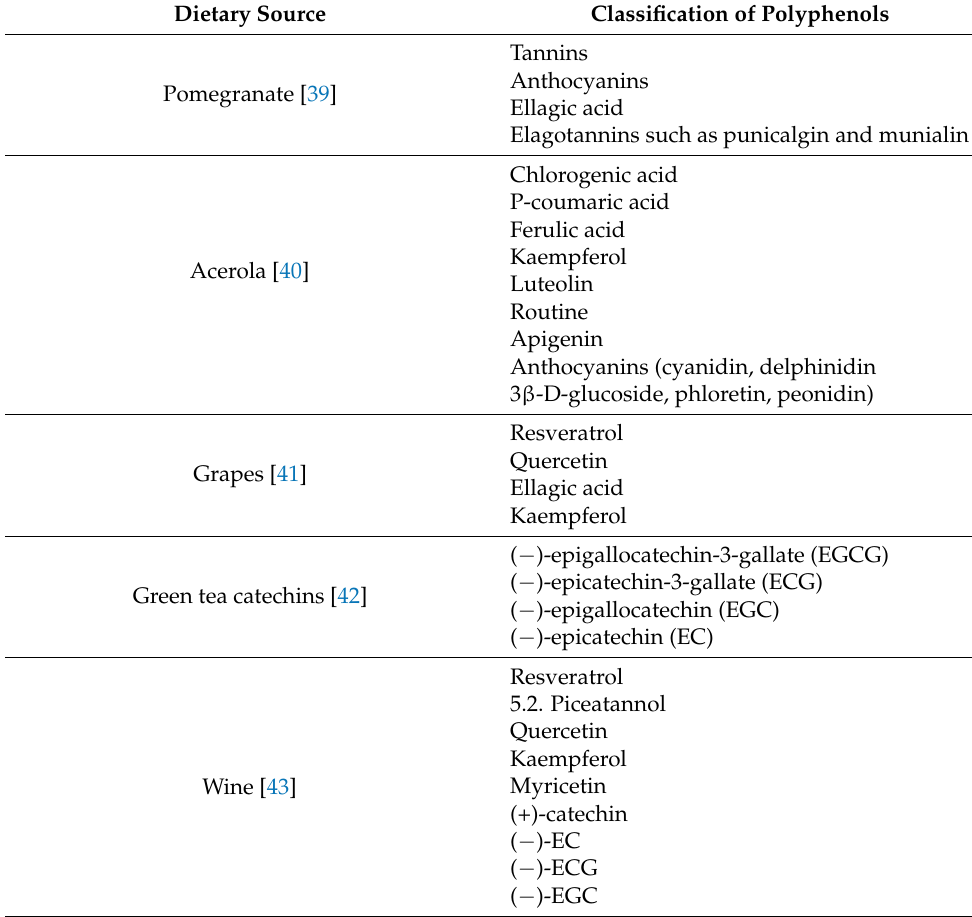
Table 1. The examples of dietary compounds rich in antioxidants. Dietary